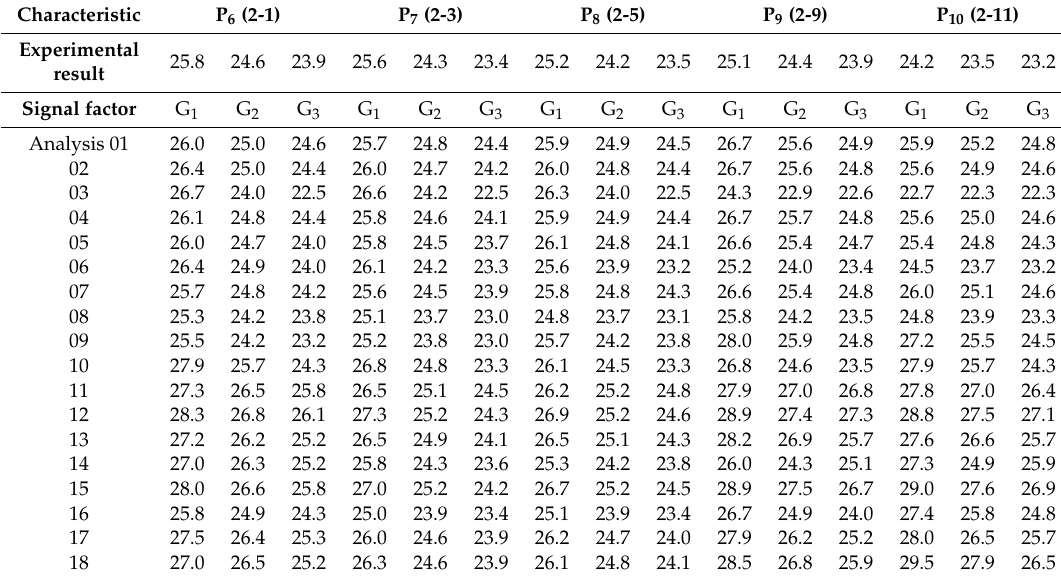
Table A2. Results of analysis based on DOE (second